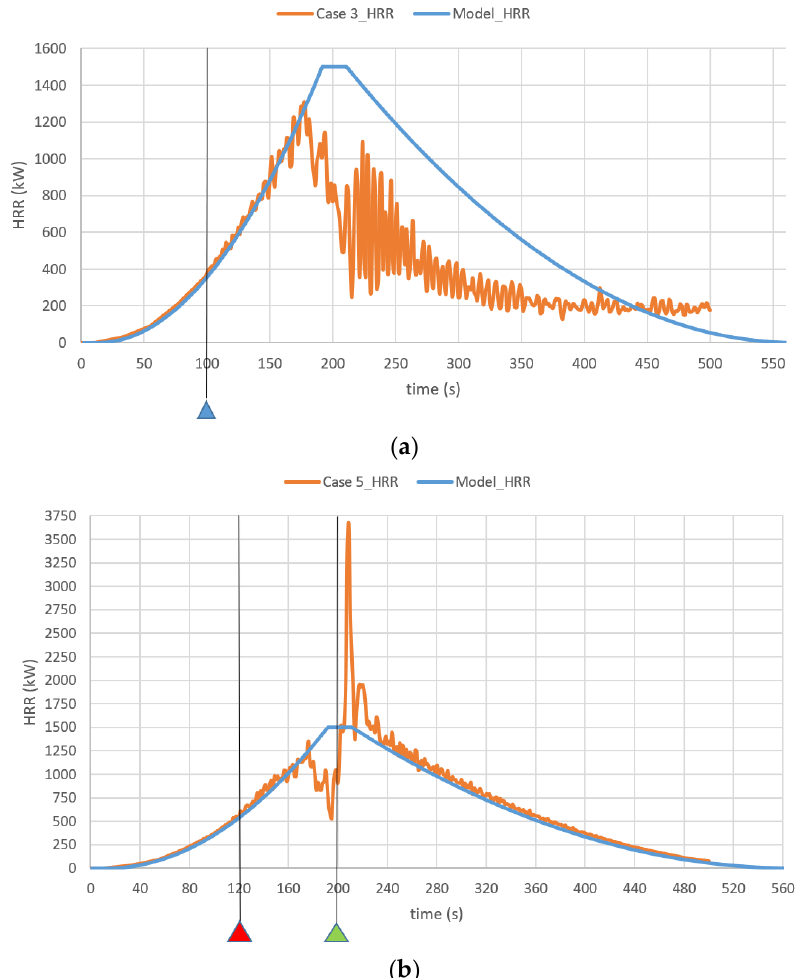
Figure 7. ( a ) Ventilation-controlled fire after growth phase φ > 1 . ( b ) Fuel-controlled fire after 200 s; φ < 1 after 200 s .